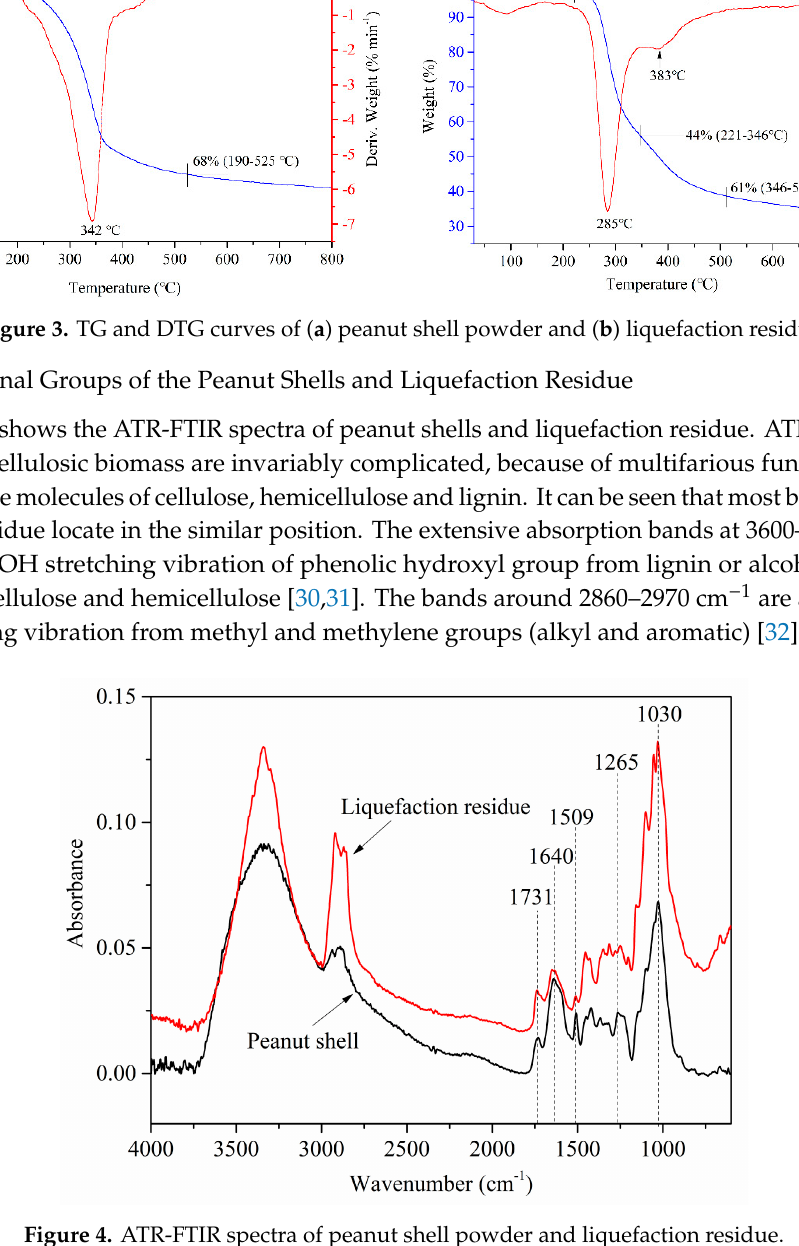
Figure 4. ATR-FTIR spectra of peanut shell powder and liquefaction residue .